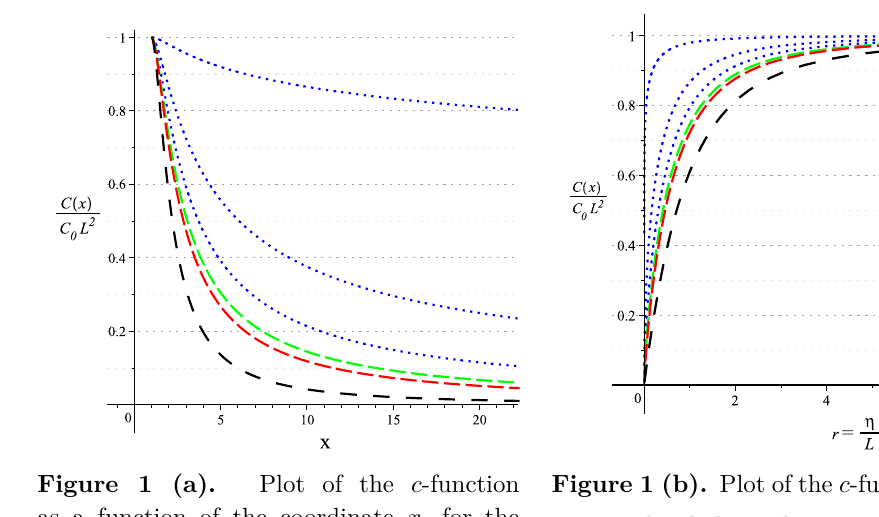
√ ν − 1 Υ ν x 2 = η for L L x ν − 1